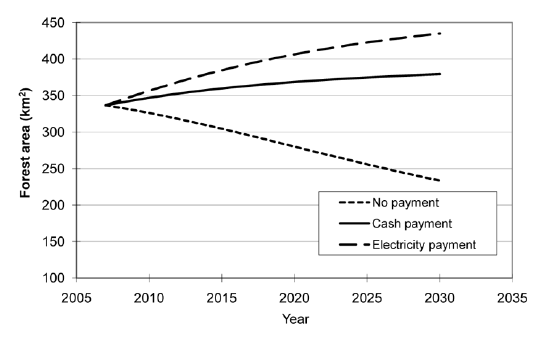
Fig. 4 . Predicted forest area under cash payment, electricity payment, and no payment scenarios. We did not draw confidence intervals because standard deviations from 30 runs are small.